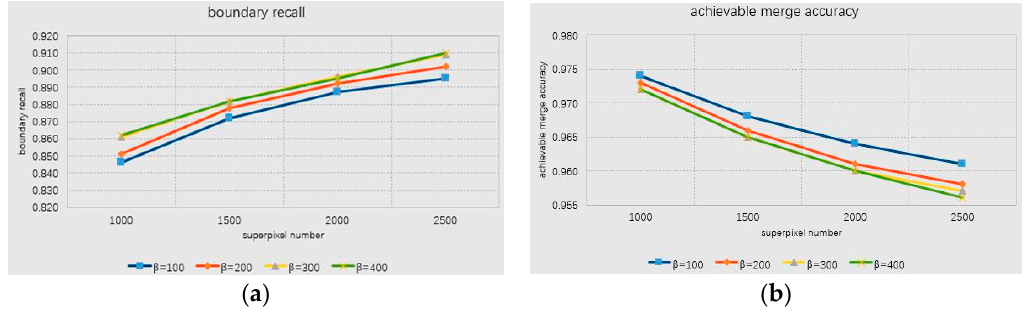
Figure 10. Different 𝛾 segmentation performances, ( a ) represents the performance curve of different 𝛾 values of boundary recall, ( b ) represents the performance of different 𝛾 values of achievable merge accuracy. We set the function 𝑓(𝑥) = −𝑥 𝑙𝑜𝑔(𝑥) , 𝛼 = 0.3 .